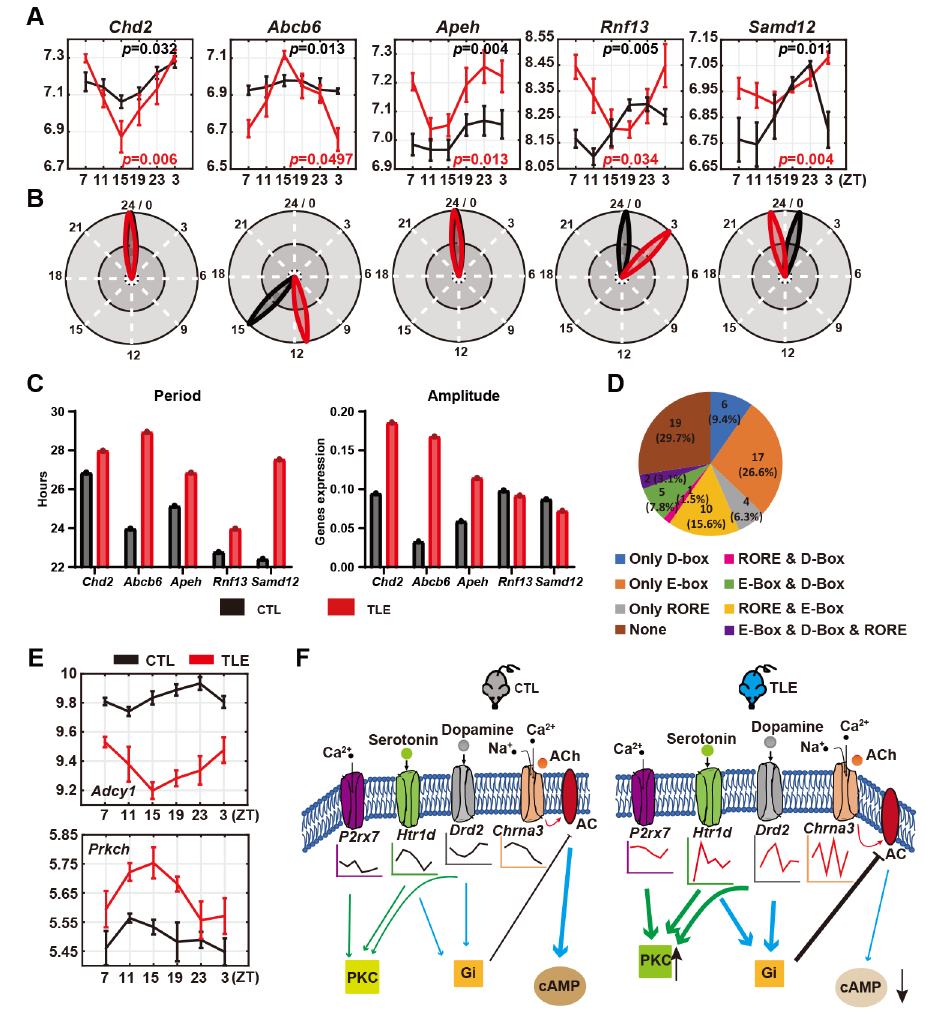
Figure 4. Analyses of five rhythmicity-maintaining epilepsy genes and circadian clock-regulated motifs in the promoters of rhythmically expressed epilepsy genes and the model for the altered cAMP signaling pathway in TLE mice. ( A ) Expression of five representative rhythmicity-maintaining genes Chd2 (Chromodomain helicase DNA binding protein 2), Abcb6 (ATP-binding cassette subfamily B member 6), Apeh (Acylaminoacyl-peptide hydrolase), Rnf13 (Ring finger protein 13), and Samd12 (Sterile alpha motif domain containing 12). ( B , C ) Altered phases ( B ), periods, and amplitudes ( C ) of five representative genes in WT and TLE mice. ( D ) Numbers of the epilepsy genes containing E - Box, D - Box, or RORE or their combinations in the 5′ 5000 - bp promoter regions. ( E ) Expression of Adcy1 (Adenylate cyclase 1) and Prkch (Protein kinase C, eta type) in CTL and TLE mice. The black curve represents gene expression values from the CTL mice, and the red curve is for those in TLE mice. ( F ) A model for the altered cAMP signaling pathway in TLE mice.